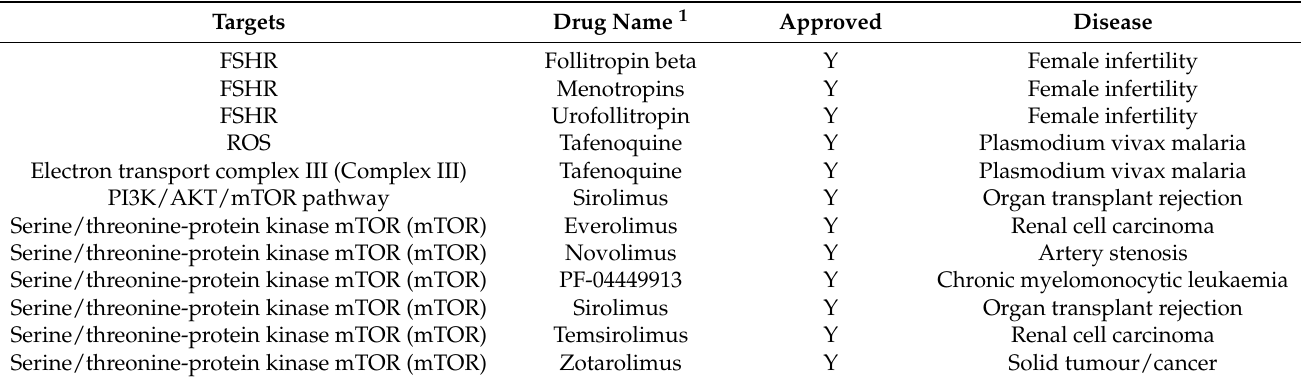
Table 2. Signaling and potential therapeutic targets explored on OMA